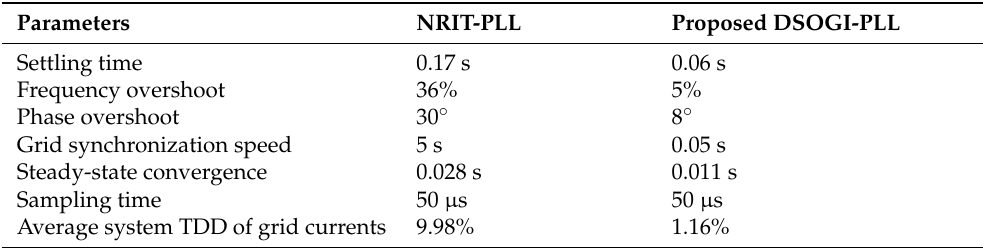
Table 6. Comparison of NRIT-PLL and proposed